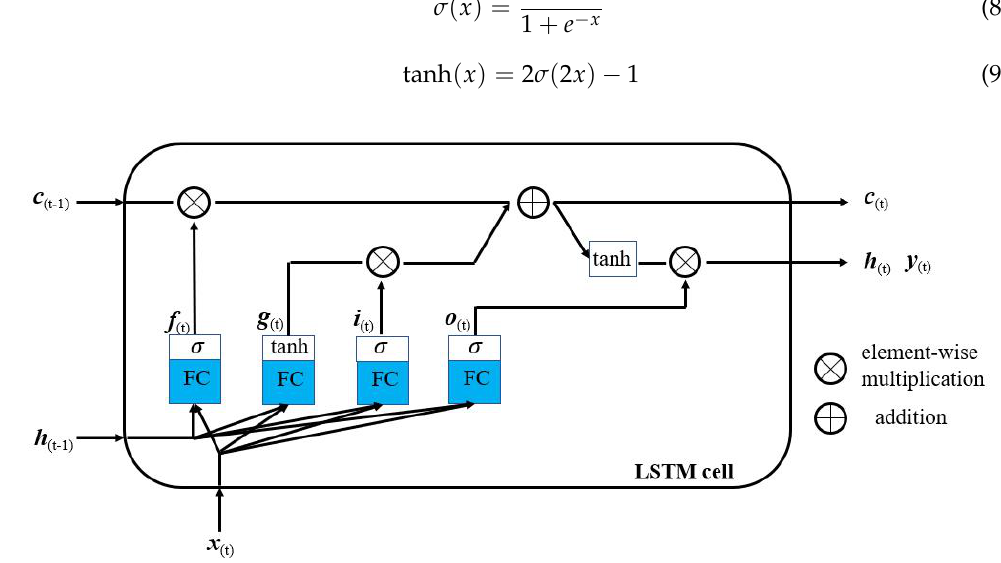
Figure 6. Sketch of the LSTM cell network diagram (after